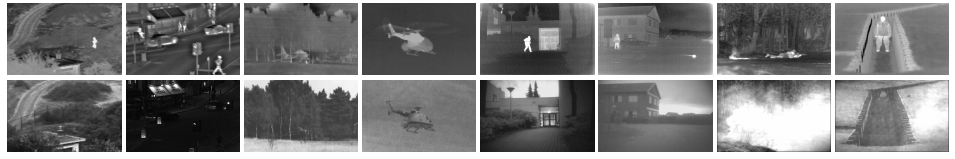
Figure 3. Illustrations of 8 pairs of testing images of the TNO dataset.